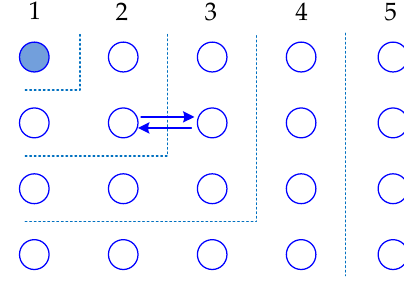
Figure 1. Hierarchical model.